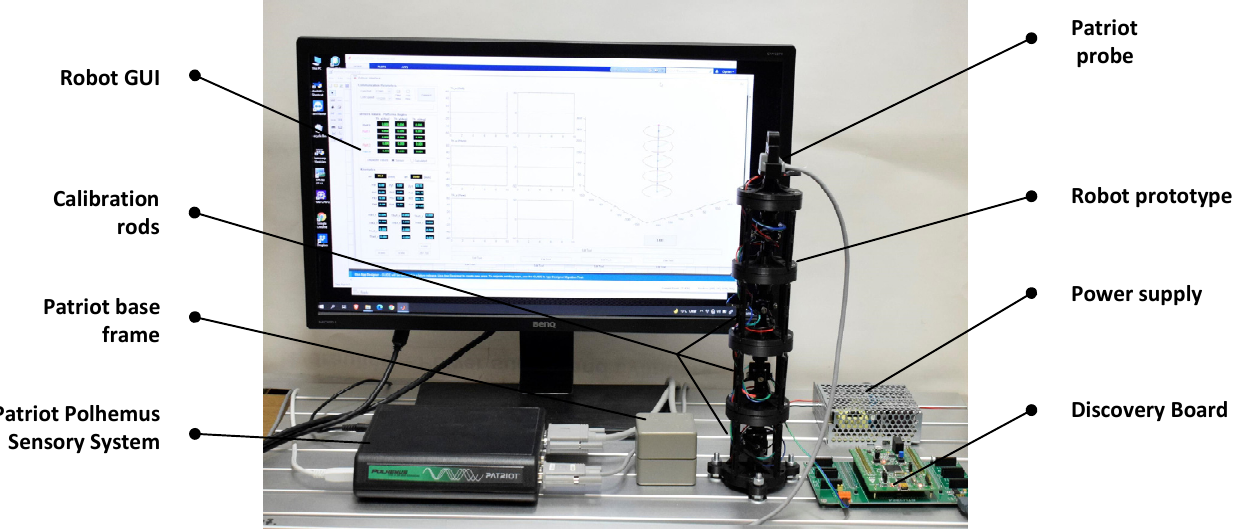
Figure 4. Experimental Stand—Robot prototype with n = 4 modules .